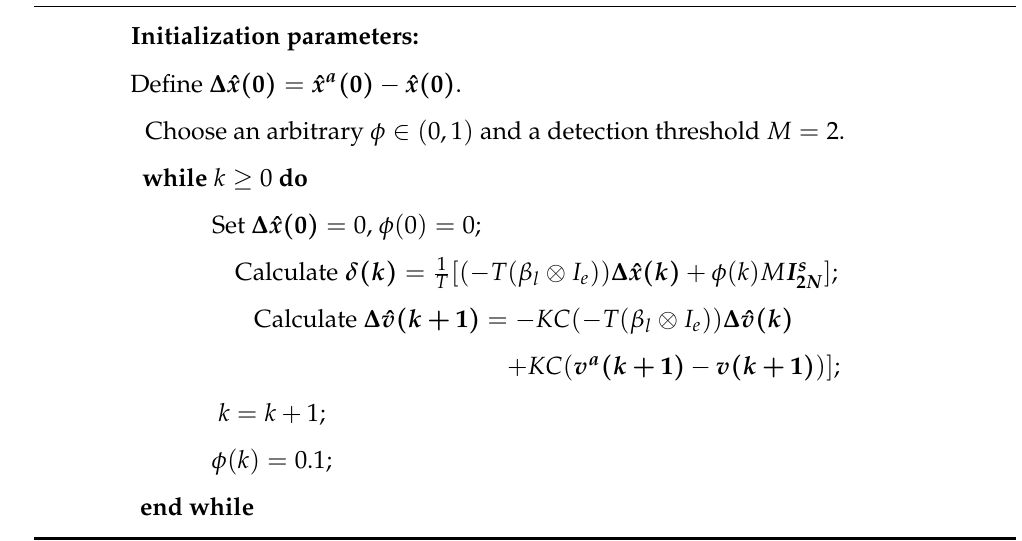
Algorithm 1 The estimation-dependent attack for the seaport